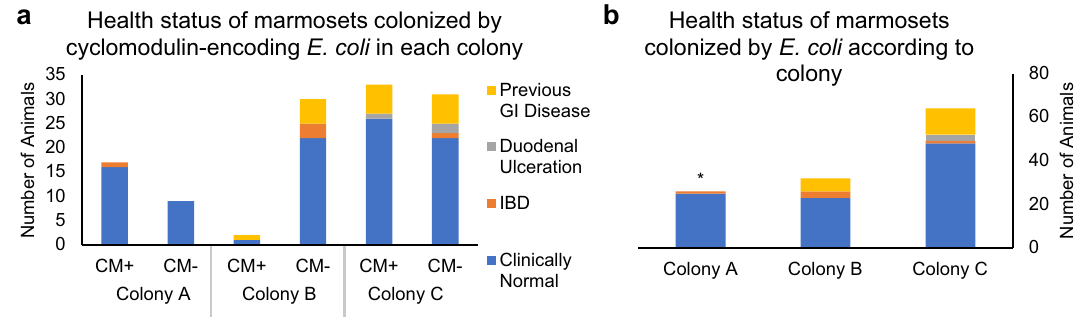
Figure 3. ( a ) Health status of captive marmosets was not significantly different between animals that were or were not colonized by cyclomodulin-encoding E. coli isolates (as determined by PCR for pks , cnf , or cdt ),